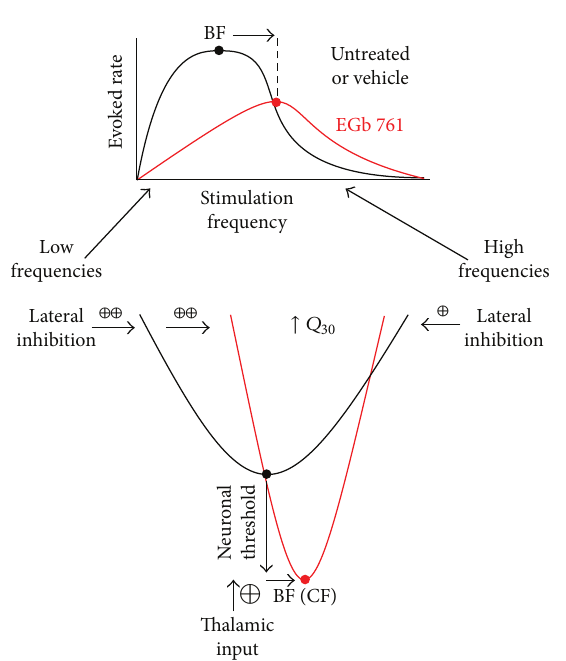
Figure 18: Proposed model of the effects of EGb 761 treatment on auditory processing. Upper panel: evoked neuronal response rate in AI for iso-intensity pure tone stimuli in vehicle (black) and EGb 761 treated animals (red). Lower panel: neuronal threshold and tuning of cortical neurons in both animal groups. Based on our data, we propose two main effects of EGb 761 on auditory processing: first, an increase of auditory brainstem activity leading to an increased thalamic input to AI, which results in lower response thresholds and shorter response latencies, and second, an asymmetric effect on lateral inhibition in AI that reduces overall response rates, shifts the best frequency (BF) to higher values, and sharpens spectral tuning ( 𝑄 30